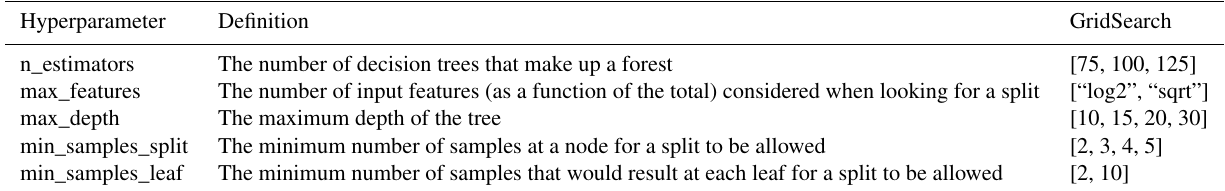
Table 2. Hyperparameter options for the random forest in scikit-learn over which a grid search optimisation was carried out (Pedregosa et al.,